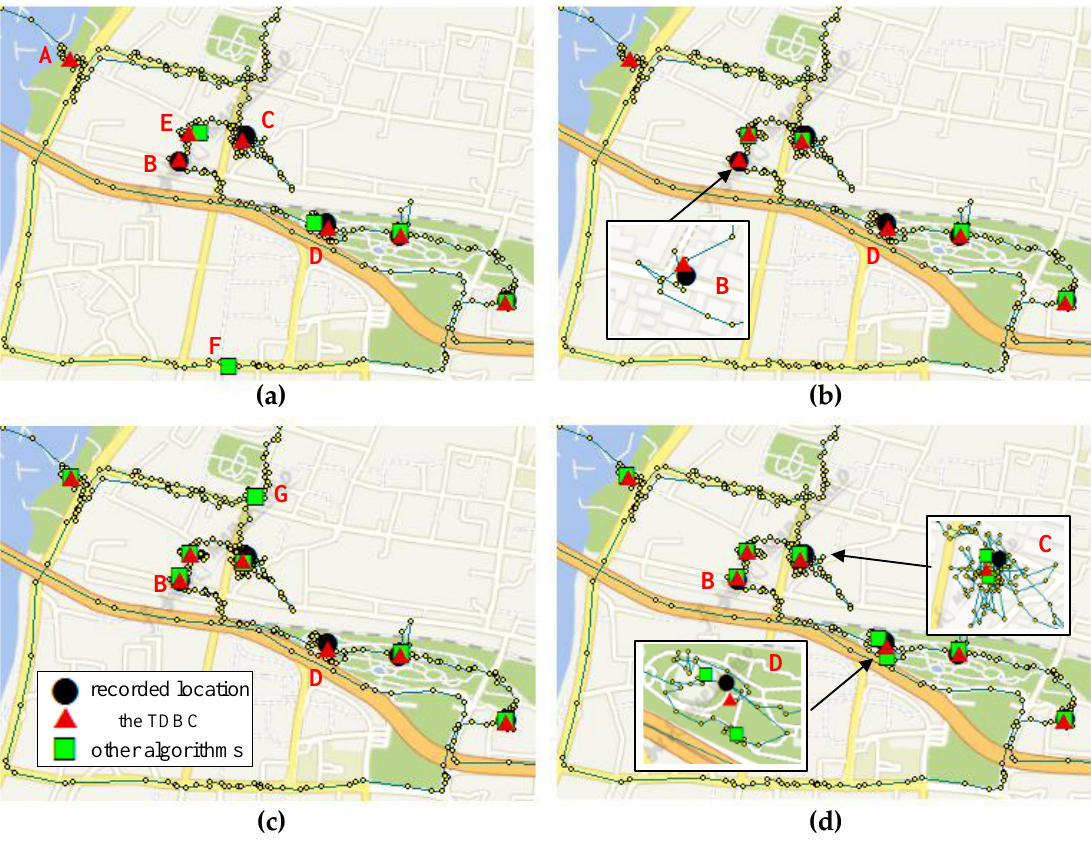
Figure 11. Results compared with other algorithms. ( a ) K-Medoids; ( b ) DJ-Cluster; ( c ) CB-SMoT; ( d ) Time-Based clustering.